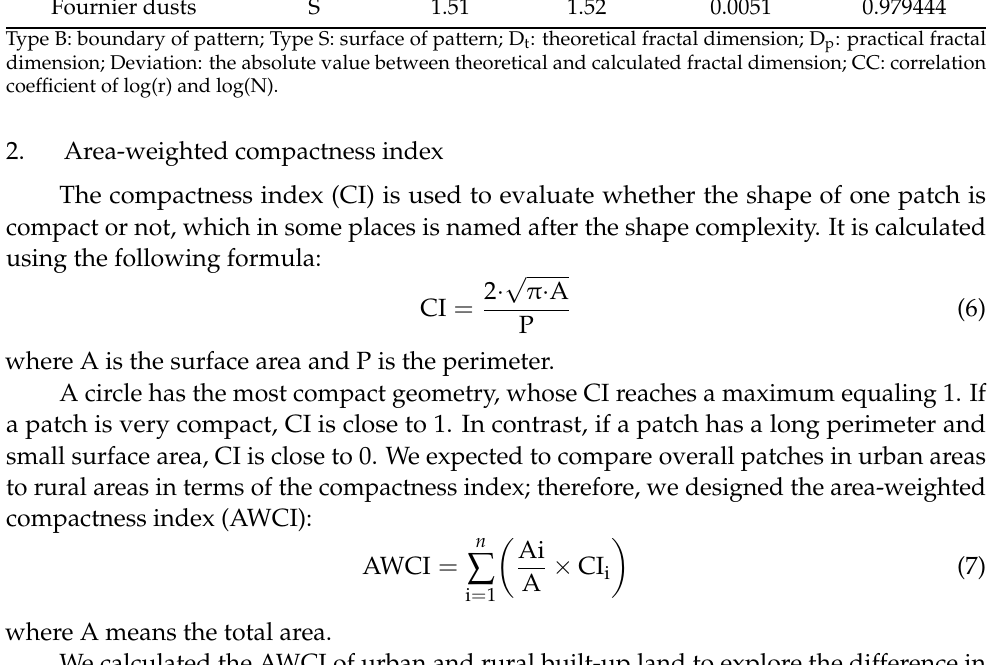
Table 2. Comparison between theoretical fractal dimensions and experimental values in Fractalyse. Pattern Type D t D p Deviation CC Circle B 1 0.95 0.0523 0.999988 Square B 1 0.98 0.0151 0.999765 Circle S 2 1.97 0.0260 0.999989 Square S 2 1.97 0.0270 0.999956 Sierpinski carpet S 1.89 0.0138